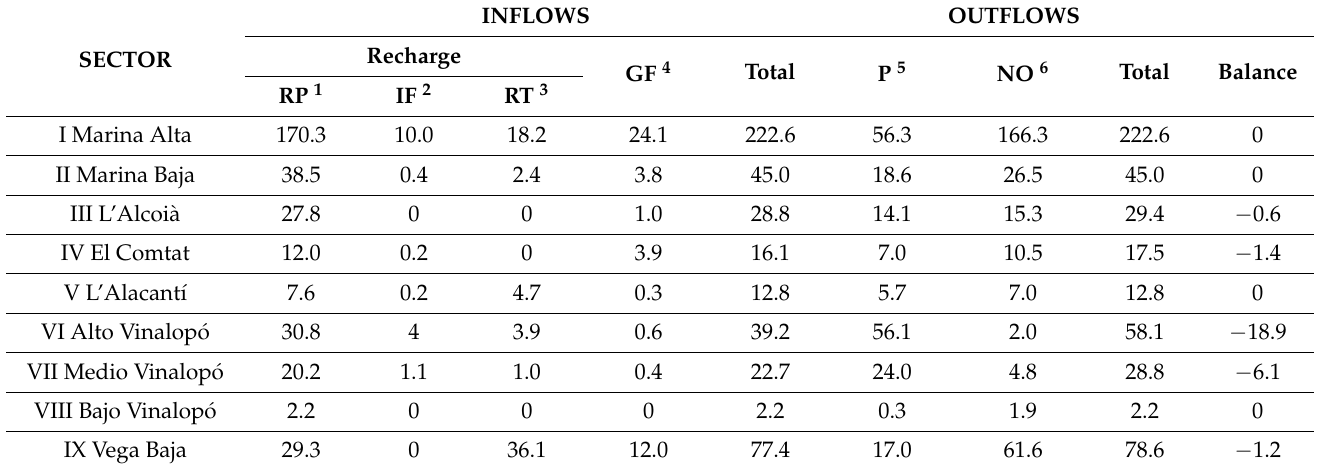
Table 2. Water balances for the aquifers of different sectors of Alicante in hm 3 /year. INFLOWS SECTOR